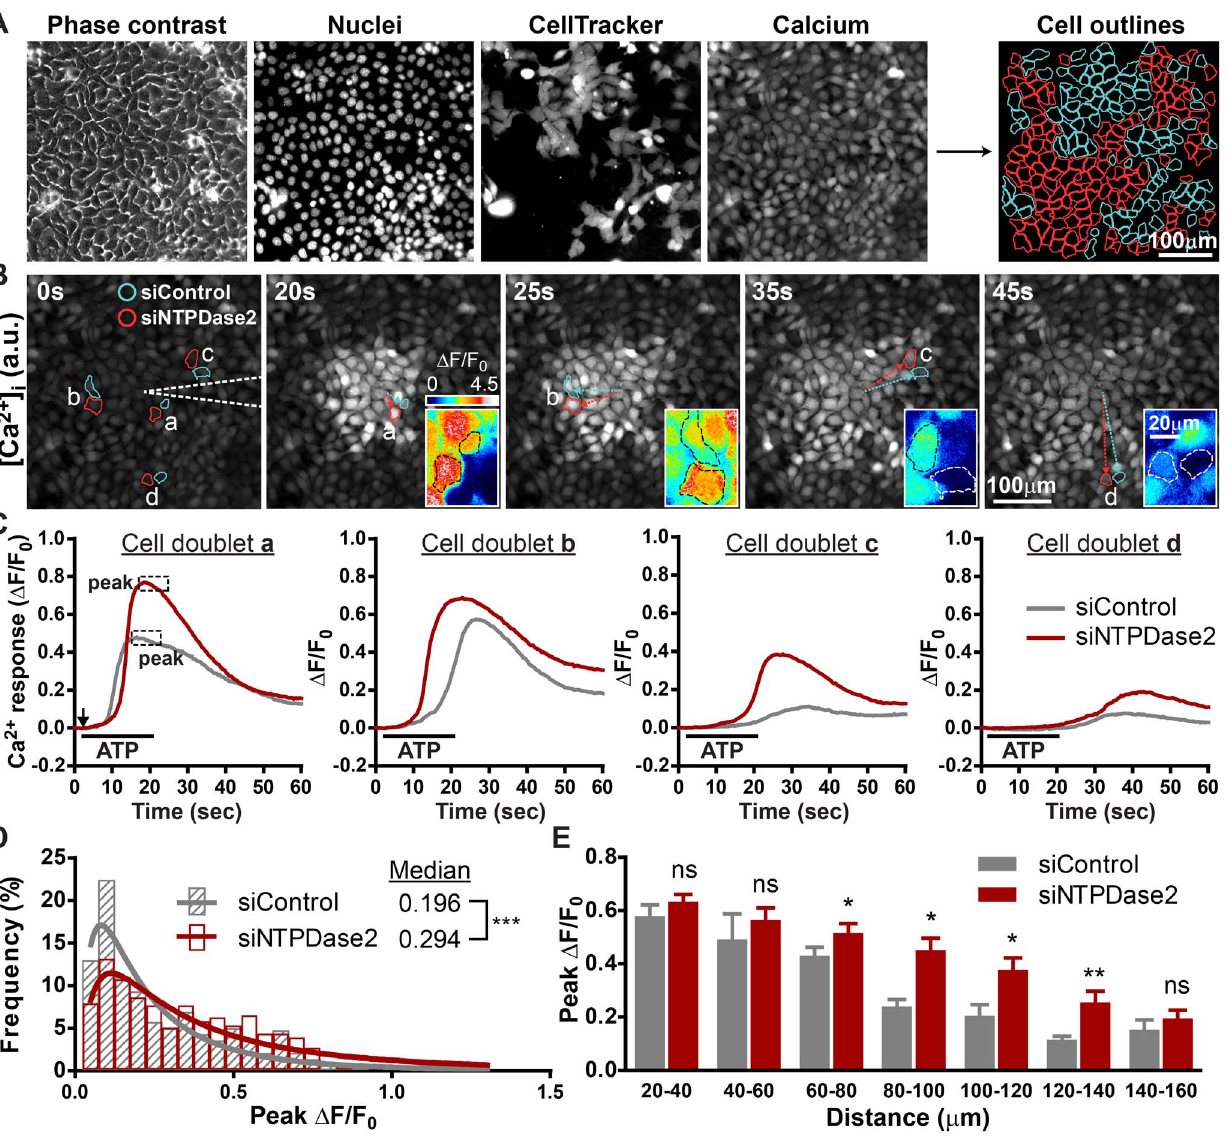
Figure 5. Knocking down NTPDase2 locally potentiates ATP-induced [Ca 2 + ] i increase. (A) Fluorescence images showing how software- assisted cell demarcation and population identification is performed according to DNA and cell tracer dye staining. Cyan lines define control cells, and red lines outline P2Y2-deficient cells. (B) Time series of fluorescence imaging of calcium wave spreading in a co-culture monolayer containing an equal ratio of control and NTPDase2-deficient HaCaT cells. White dotted lines indicate the position of the glass needle. Insets: enlarged pseudo-color images of control and NTPDase2-deficient cell pairs depicted in D F/F 0 . Dotted lines define the cell outline (a.u., arbitrary unit). (C) Traces showing Ca 2 + change (fold change from baseline, D F/F 0 ) in individual control (gray) and NTPDase2-deficient (red) cells from panel B. The black arrow indicates the initiation of ATP point release, and the black line defines the duration of ATP point release (a.u., arbitrary unit). (D) Frequency distribution and log Gaussian fit comparing the peak Ca 2 + change between control (gray) and NTPDase2-deficient (red) cells. (414 vs. 422 cells pooled from 5 calcium waves, Mann-Whitney test was used to determine statistical significance). (E) Bar graph comparing the average median peak [Ca 2 + ] i response between control and NTPDase2-deficient cells within the same range relative to the needle tip (mean 6 SEM, n=5 calcium waves, Student’s t test, * p , 0.05; ** p , 0.01; ns=not significant).